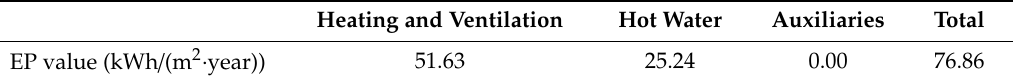
Table 14. The annual primary energy demand (kWh / (m 2 · year)) for the multi-family building